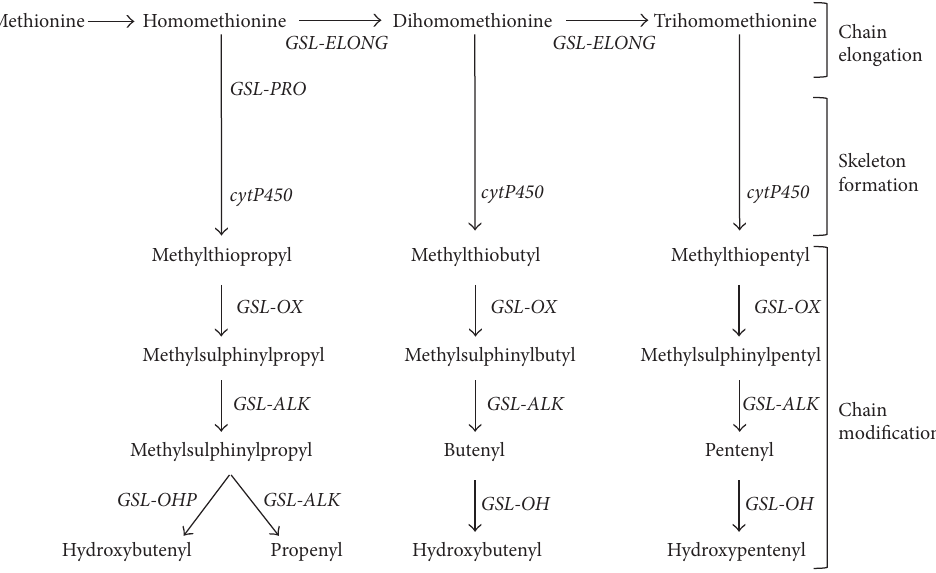
Figure 2: Simplified model of the biosynthesis pathway of aliphatic glucosinolate in Brassica [19,